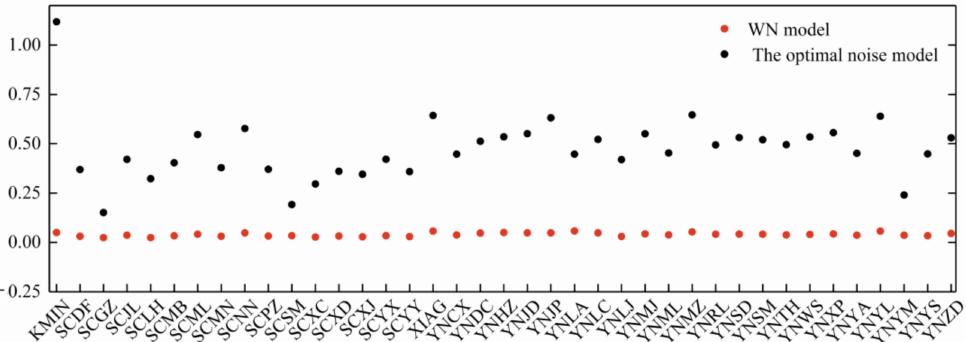
Figure 9. Velocity uncertainty before HYDL correction associated with the WN model and optimal noise model.